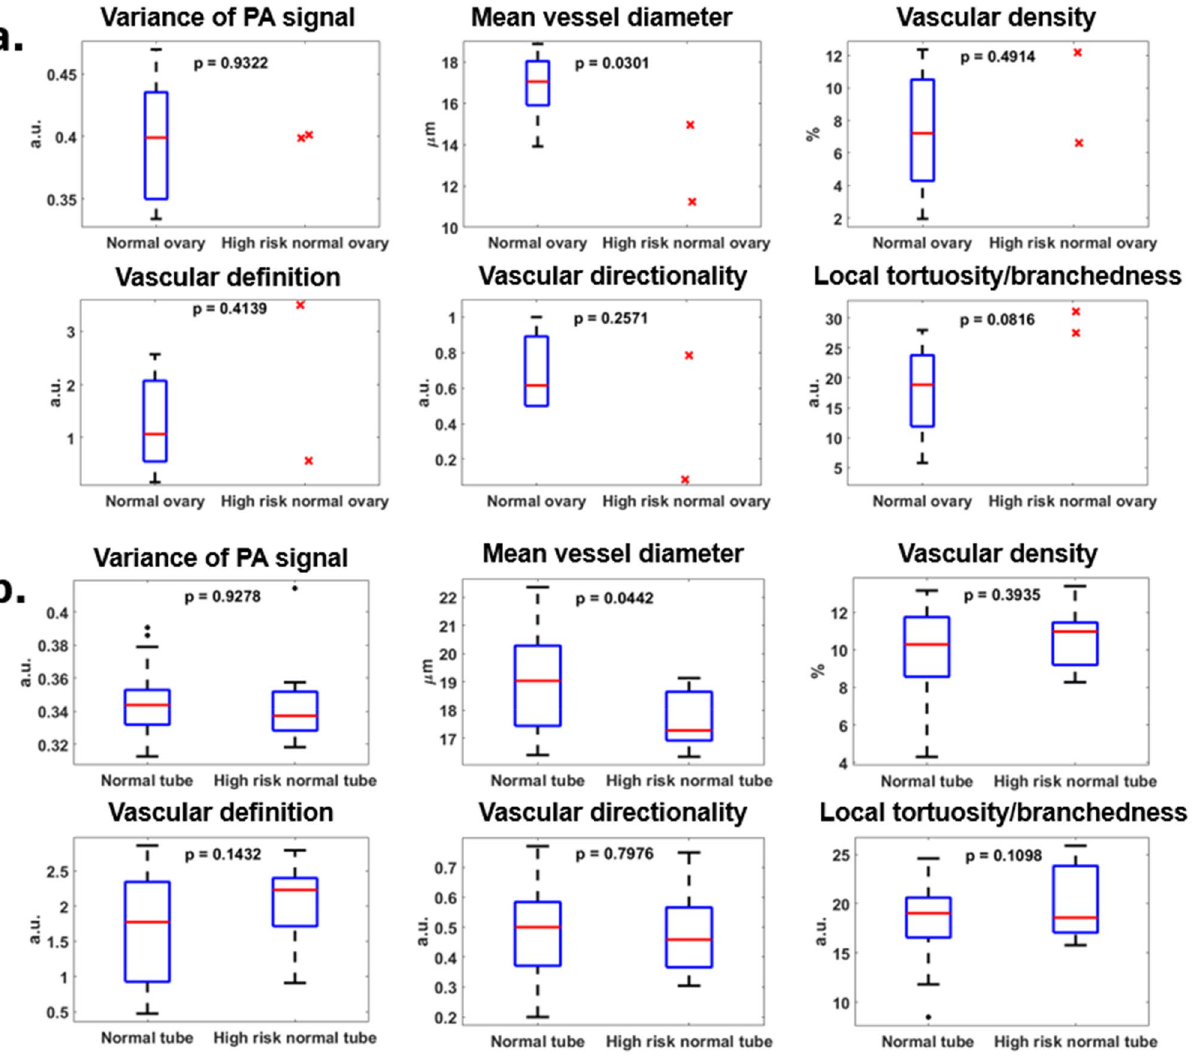
Figure 9. Comparison of morphological vascular feature differences between normal specimens with and without high-risk genetic indicators for ovarian cancers. ( a ) Among ovary specimens, 2 out of 10 cases were high-risk. ( b ) Among tube specimens, 11 out of 32 cases were